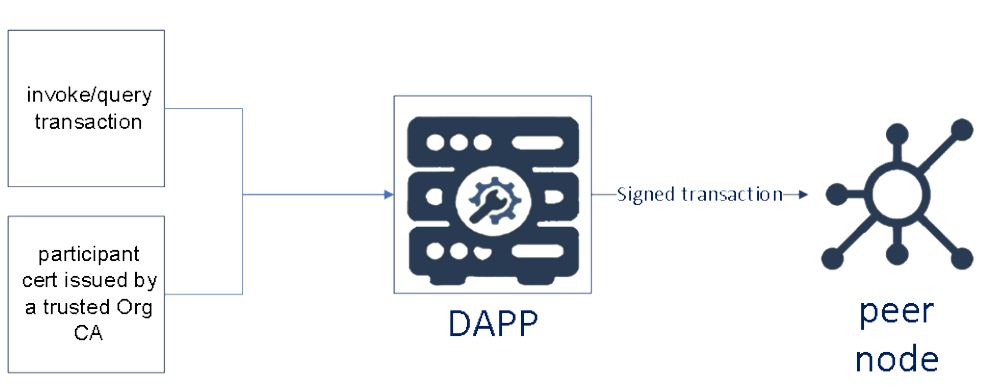
Figure 6. Invoke/Query transaction to peer via